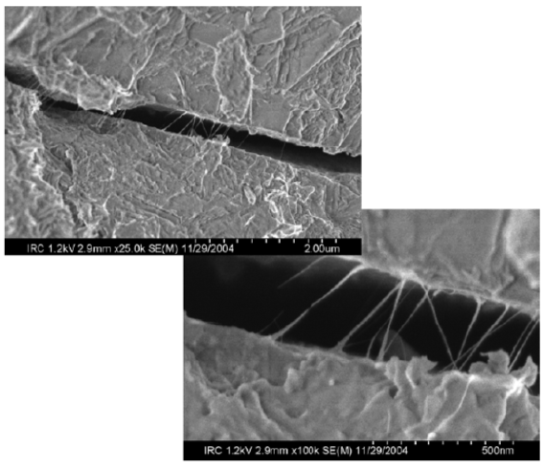
Figure 2: Crack bridging effect in cement/CNTs composites